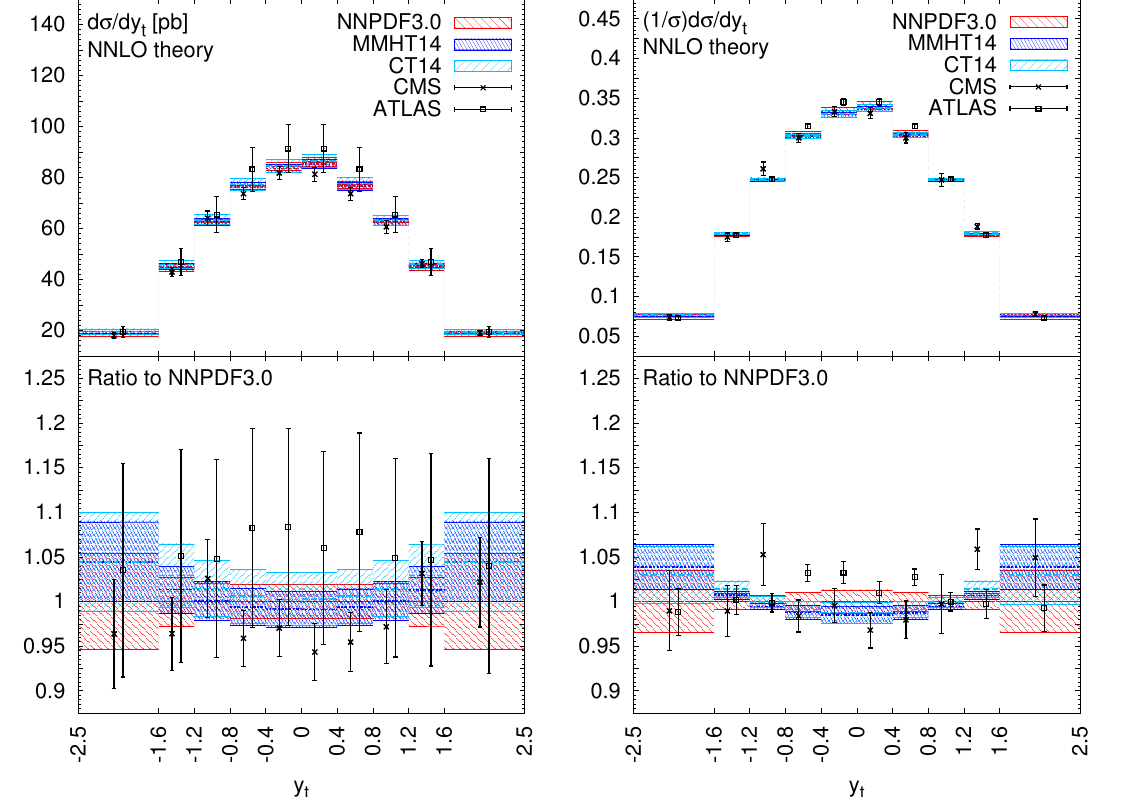
Figure 7 . Same as (cid:12)gure 5 for the top quark rapidity distribution y t . overshoots the predictions of the other two PDF sets and the data for central rapidities and undershoots them in the forward